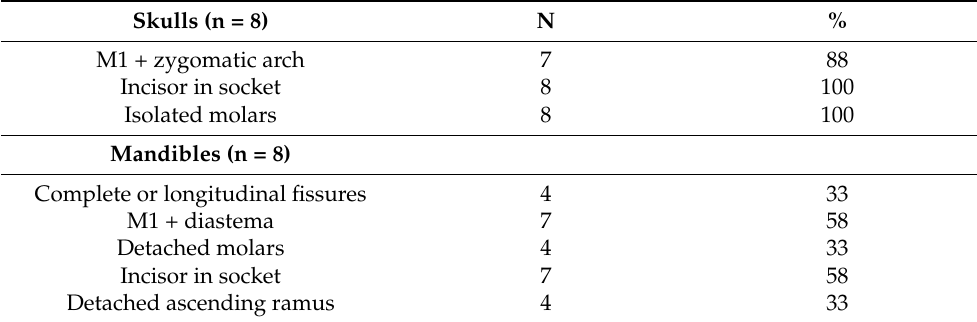
Figure 6. Breakage of the skull is more severe when it is compressed on the ventral aspect ( A ) rather than from the dorsal position ( B ) The red arrow points to the incisors in the interior of their sockets. Table 3. Representation of cranial parts after the three steps of compression under both dry and wet conditions. Skull fragmentation appears not to be very severe, and most skulls remain attached but deformed (especially in compressed wet skulls), but any further processing of these specimens causes their disintegration into small fragments. Similarly, mandibles compressed wet remain complete. Those compressed dry may have fissures, especially affecting the ascending